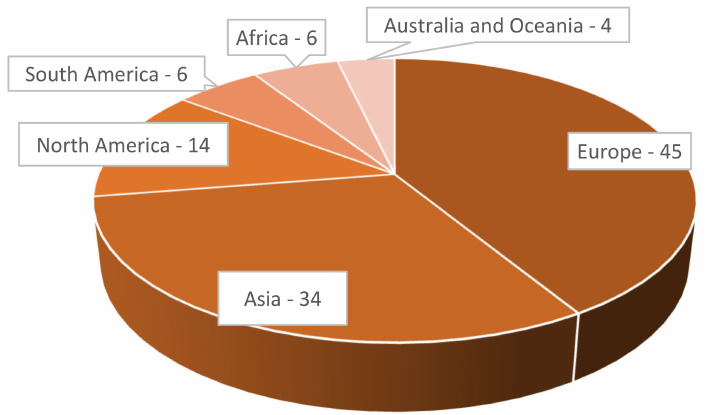
Figure 1. Number of cities in the Smart City Index 2020 ranking by particular continents. Source: author’s work based on